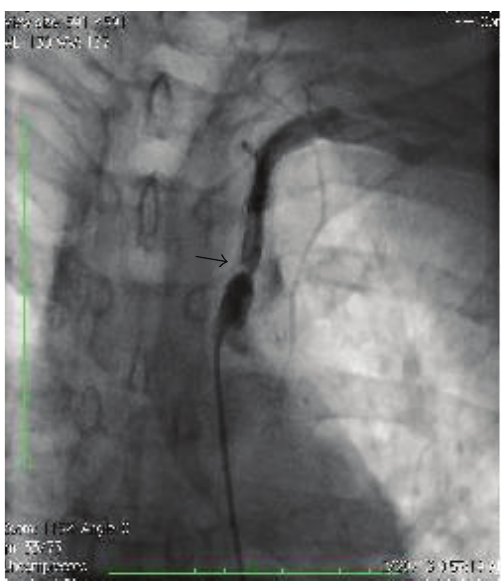
Figure 1: Angiogram showing occluded proximal left subclavian artery.